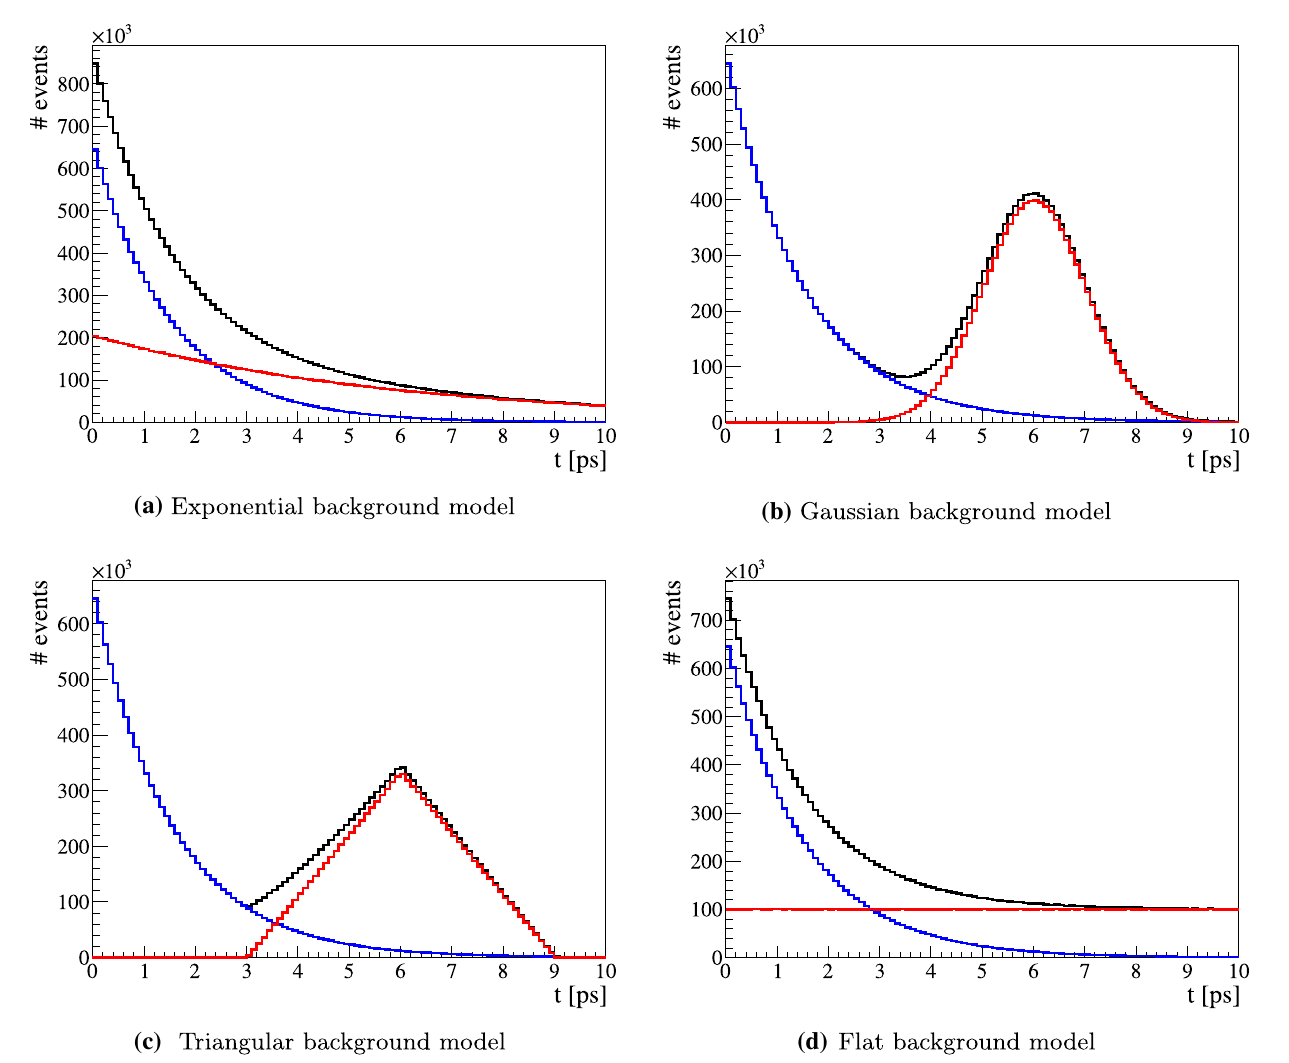
Fig. 7 Decay time distributions for the four different background options for (black) the full data, (blue) signal and (red) background. The signal and background components are obtained using